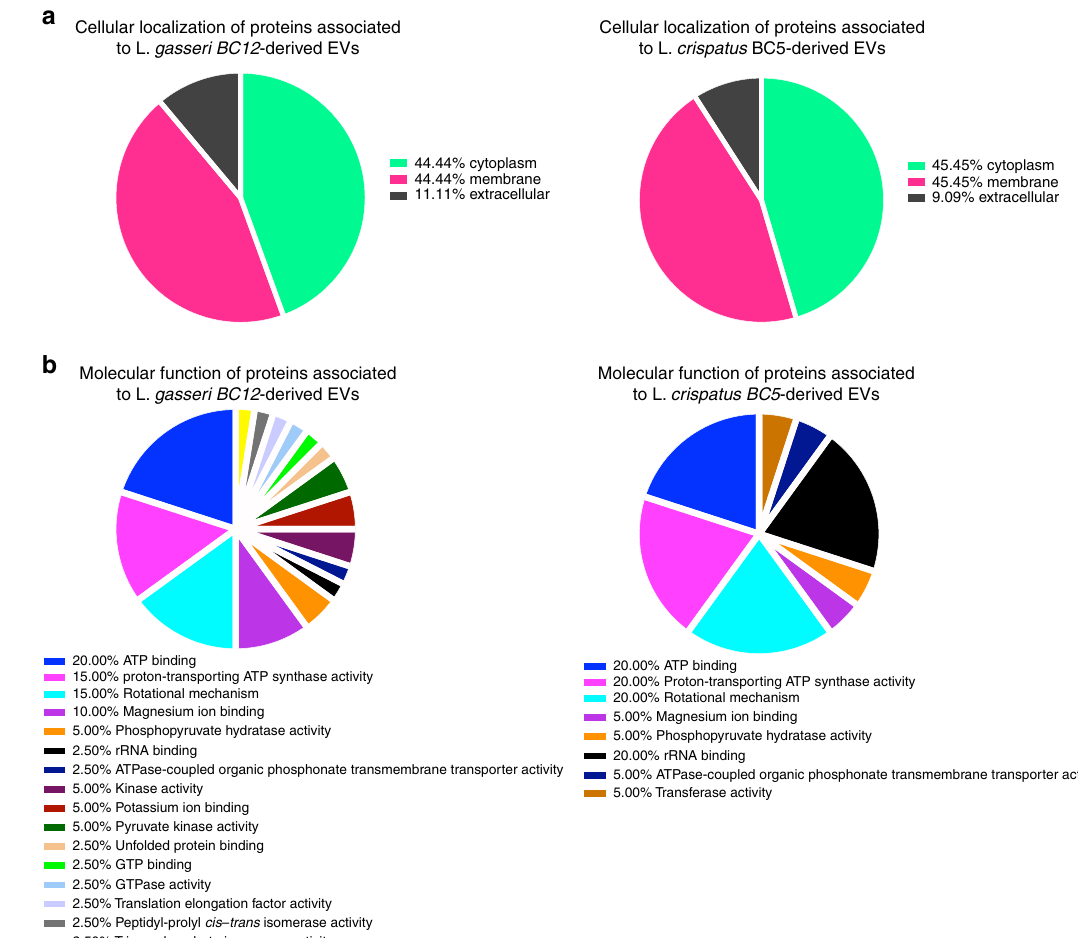
Fig. 9 GO terms of EV-related proteins. a According to cellular localization. b According to biological